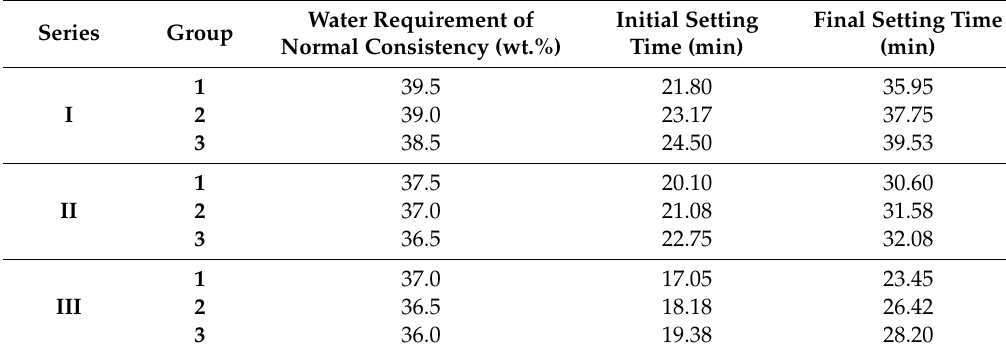
Table 5. Physical properties of cement